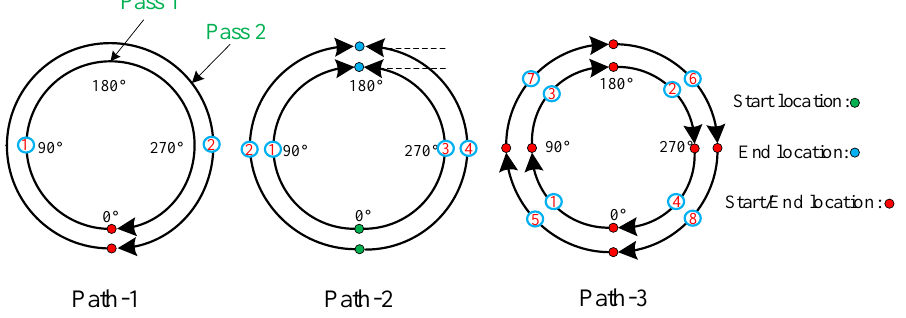
Figure 7. Three welding sequence settings.